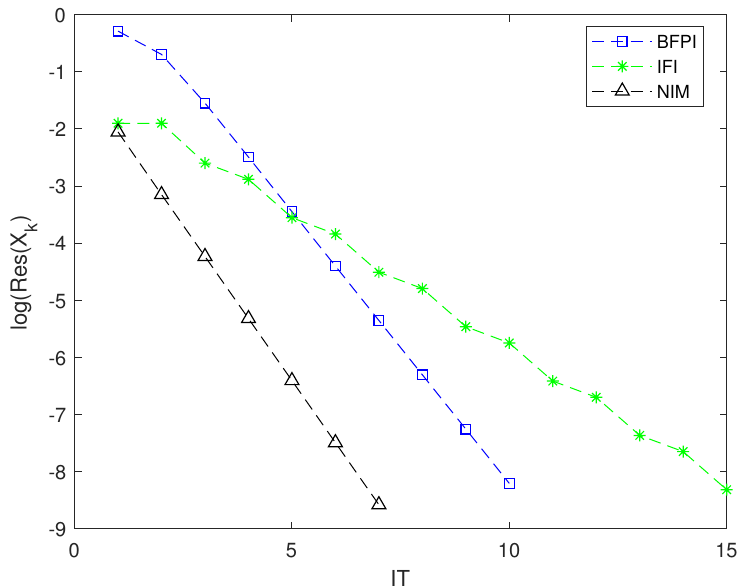
Figure 1. The convergence process of the three iterations for computing Equation (1) for Example 1.